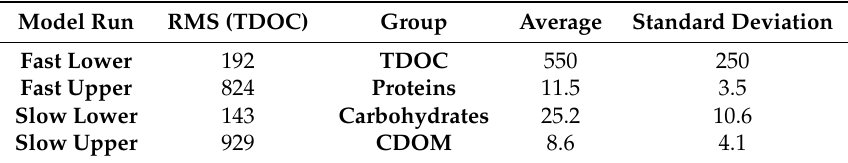
Table 4. Standard analysis of dissolved carbon results divided into (1.) a left hand portion with the root mean square (RMS) taken relative to the total organic measurements downstream of Yakutsk, and (2.) the total plus functional group distributions at many peripheral exits organized to the right. All values are in the micromolar of elemental carbon except CDOM as attenuation per meter.